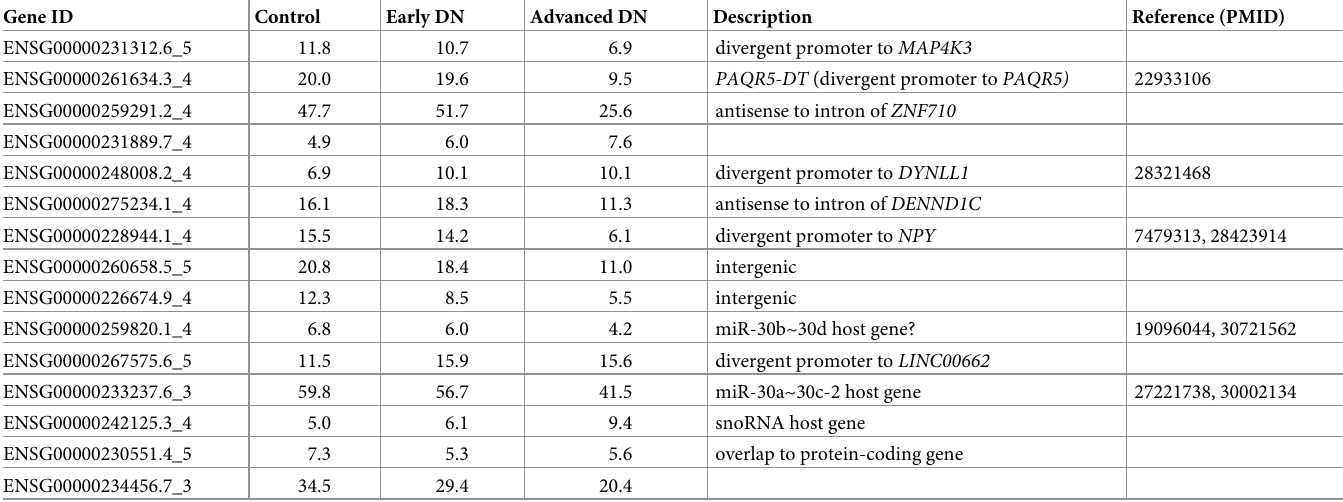
The FPKM value and genomic information for each lncRNA are shown. The PubMed ID (PMID) of up to two of the most relevant references for those lncRNAs whose neighboring genes have been shown to be involved in the pathogenesis of diabetes have also been